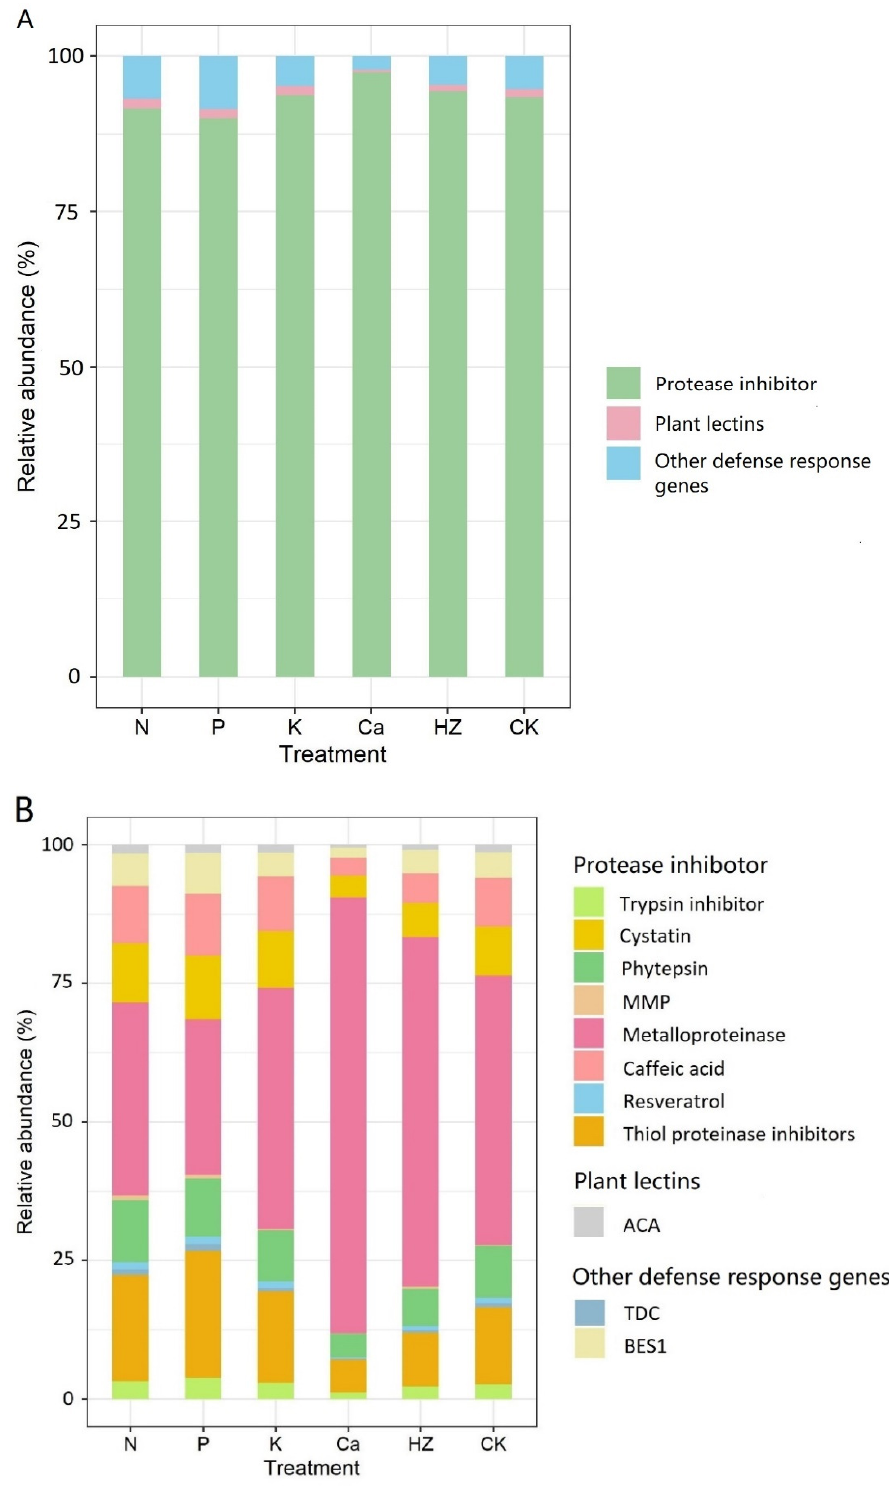
Figure 2. Identification of insect-defense response genes in Z. bungeanum . The boxplots represent the percentage of FPKM value of the “Protease inhibitor,” “Plant lectins,” and “Other defense response genes” families in Z. bungeanum for N, P, K, Ca, and HZ treatments and CK groups ( A ). The stacked bar represents the percentage of FPKM value of the unigenes related to “Protease inhibitor,” “Plant lectins,” and “Other defense response genes” gene families. The relative abundance of each gene in the N, P, K, Ca, HZ, and CK groups is shown by each bar with different color legends ( B ).